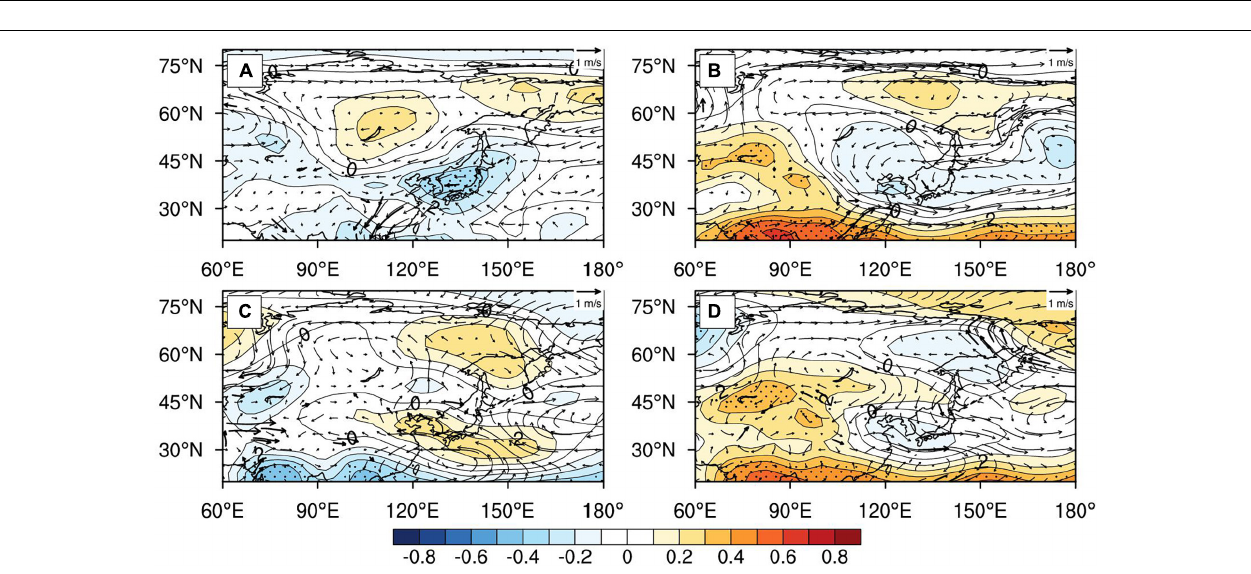
FIGURE 8 | Spatial distribution of the correlation coefficients between the summer NCCV indexes and the proceeding spring SST anomalies during 1979–2018. (A) EM type; (B) SLM type; (C) ESM type; (D) SSM type. Dotted areas indicate the 99% confidence level.